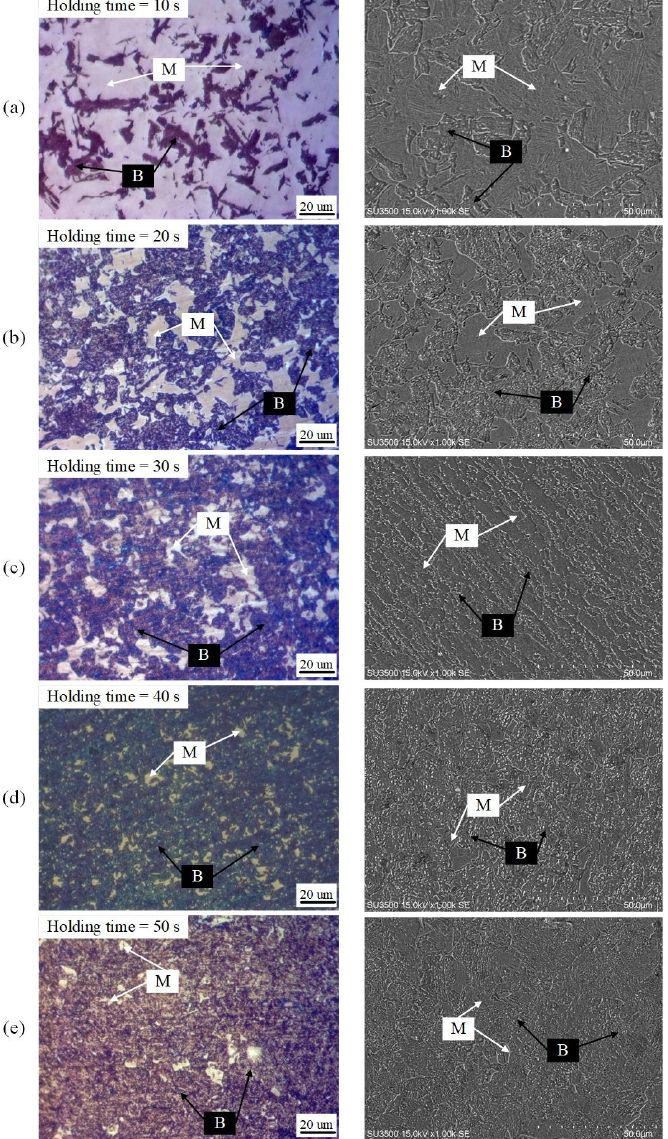
Figure 2. Optical micrographs ( left ) and SEM images ( right ) of heat-treated samples with varying holding times ( a ) 10 s, ( b ) 20 s, ( c ) 30 s, ( d ) 40 s, and ( e ) 50 s (In the figure, B and M represent bainite and martensite, respectively.).